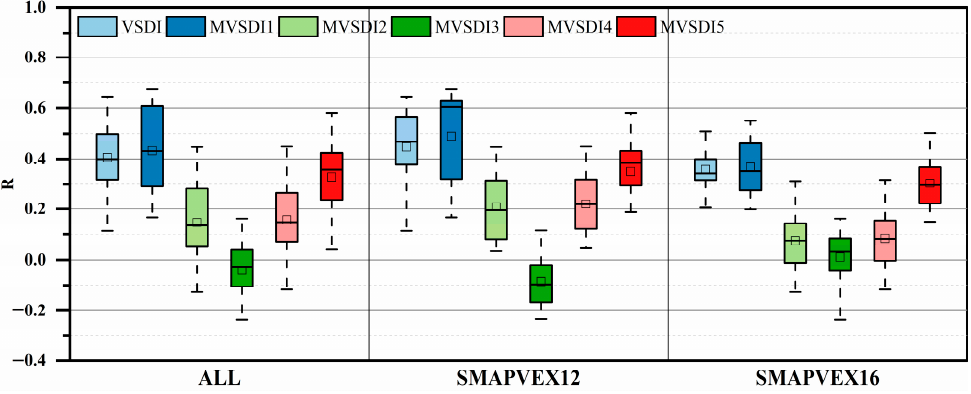
Figure 11. Comparisons between VSDI, modified VSDIs, and aircraft SM.